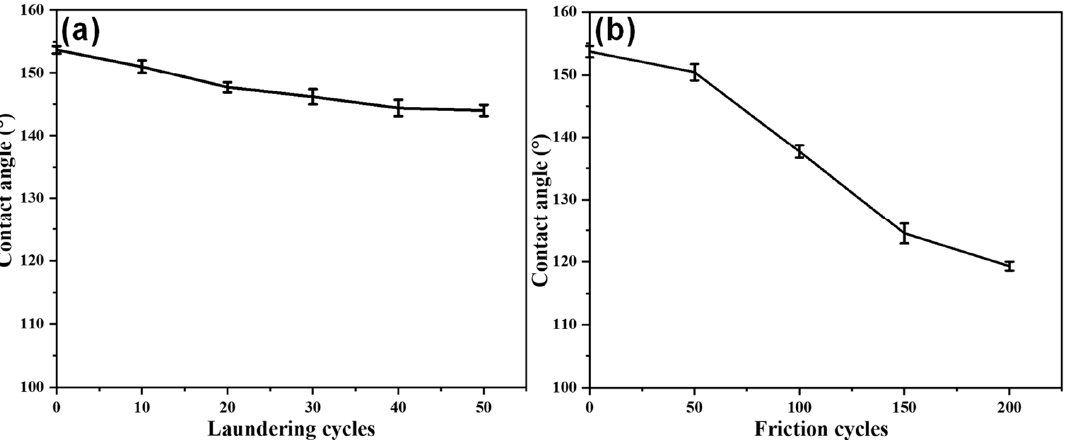
Figure 10. Effect of laundering cycles ( a ) and friction cycles ( b ) times on the CA of the CS/APP@TiO 2 - SiO 2 -HMDS.